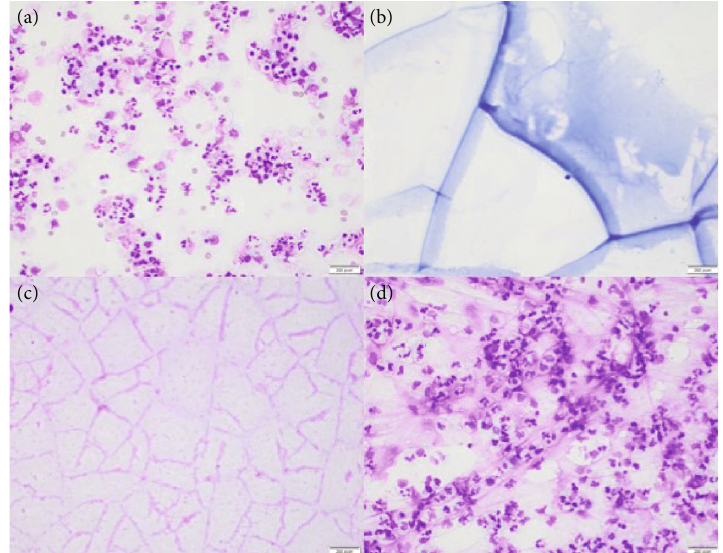
Figure 1: Clockwise from upper left: (a) UPE with discordant cytology smear showing marked cellularity comprised of PMNs, monocytes, and cellular debris in the background. (b) UPE with concordant cytology smear showing proteinaceous, paucicellular fl uid with window paning. (c) CPE with discordant cytology smear demonstrating a very similar appearance to (b) with paucicellular, proteinaceous fl uid, and (d) CPE with concordant cytology smear showing marked cellularity with admixed PMNs and monocytes and an abundance of fi brinous debris in the background. (Wright Giemsa stains, a –